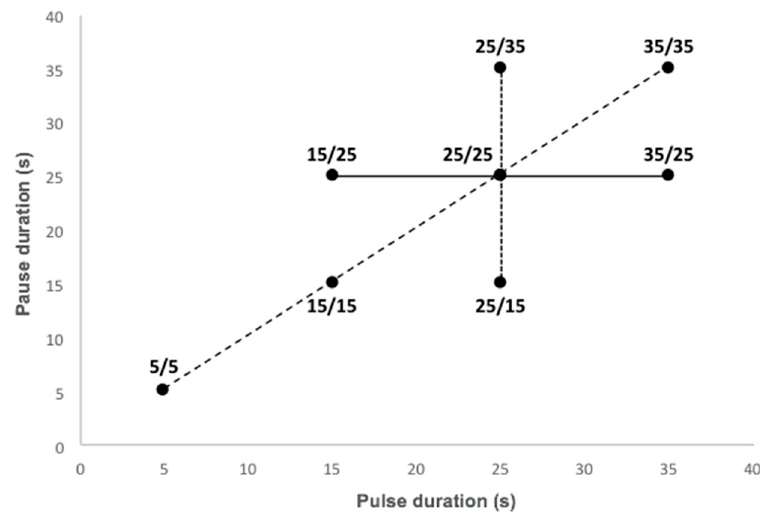
Figure 2. Surface area covered by the eight PEF conditions tested. The solid line, short dashes, and long dashes regroup conditions selected to study respectively pause duration, pulse duration, and frequency variation effect on acid whey electrodialysis.